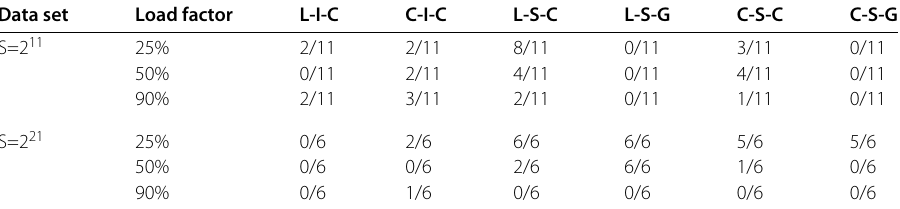
Table 3 The performance of Murmur hashing with groups of different numbers Data set